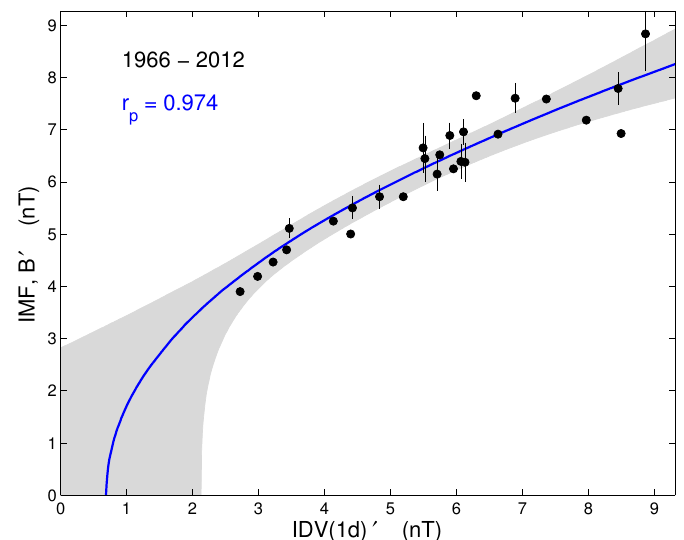
Figure 32: Scatter plot of annual means (with piecewise removal of datagaps) of 𝐼𝐷𝑉 (1 𝑑 ) ′ and IMF 𝐵 ′ , showing the results of a polynomial fit of the functional form 𝐵 = 𝜒. ( 𝐼𝐷𝑉 (1 𝑑 ) ′ − 𝛽 ) 𝛼 . The blue line is the median of 100 000 best polynomial fits and grey area defines the 2 𝜎 uncertainty band, derived using a Monte-Carlo technique, allowing for the distributions of uncertainties introduced by the IMF orientation factor 𝑠𝑖𝑛 4 ( 𝜃/ 2) and the experimental uncertainties in both 𝐵 and 𝐼𝐷𝑉 (1 𝑑 ). The linear correlation coefficient of fitted and observed IMF is 0.947. The error bars on datapoints allow for the effect of the